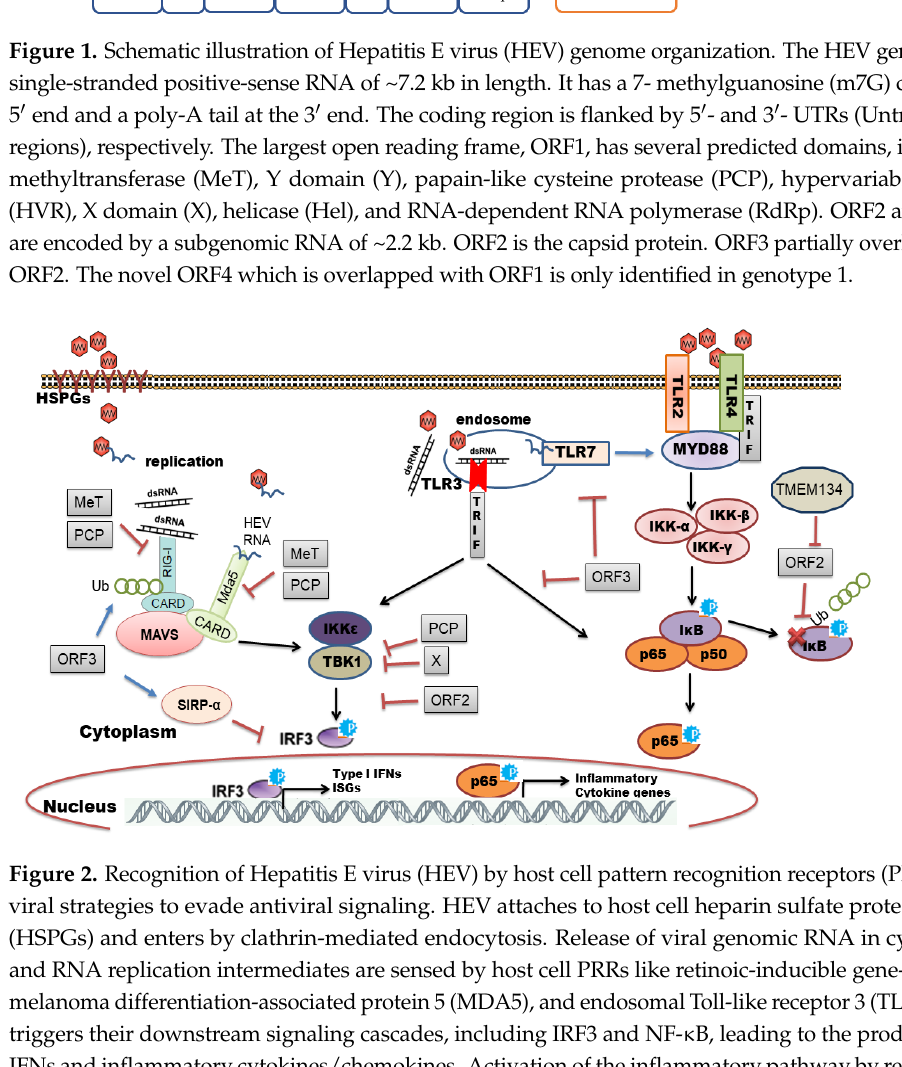
Figure 1. Schematic illustration of Hepatitis E virus (HEV) genome organization. The HEV genome is a single-stranded positive-sense RNA of ~7.2 kb in length. It has a 7- methylguanosine (m7G) cap at the 5 ′ end and a poly-A tail at the 3 ′ end. The coding region is flanked by 5 ′ - and 3 ′ - UTRs (Un- translated regions), respectively. The largest open reading frame, ORF1, has several predicted do- mains, including methyltransferase (MeT), Y domain (Y), papain-like cysteine protease (PCP), hy- pervariable region (HVR), X domain (X), helicase (Hel), and RNA-dependent RNA polymerase (RdRp). ORF2 and ORF3 are encoded by a subgenomic RNA of ~2.2 kb. ORF2 is the capsid protein. ORF3 partially overlaps with ORF2. The novel ORF4 which is overlapped with ORF1 is only iden- tified in genotype 1.